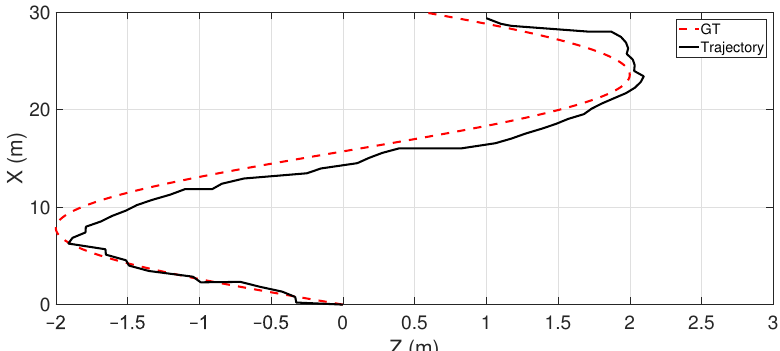
Figure 12. z -axis coordinate tracking for test 2.